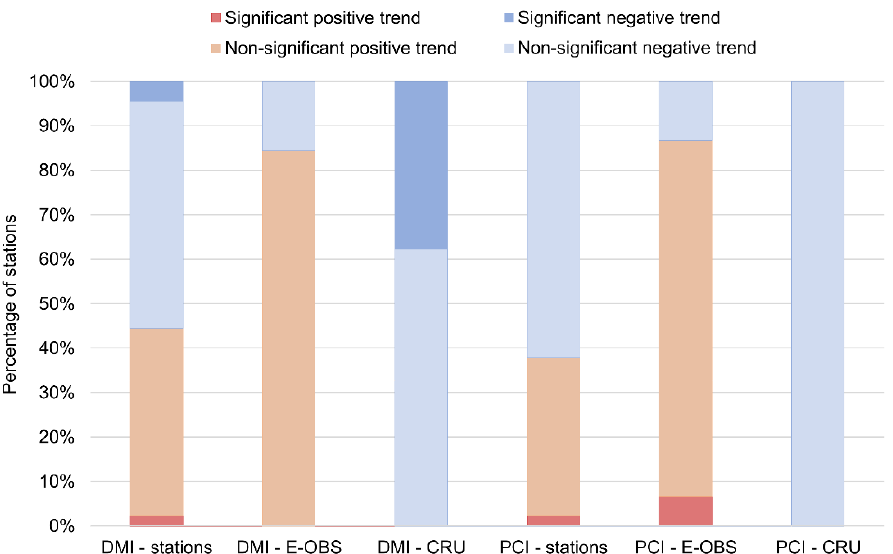
Figure 6. Results of trend analysis for the time series of the De Martonne (DMI) and Pinna combinative (PCI) aridity indices based on the different selected datasets.